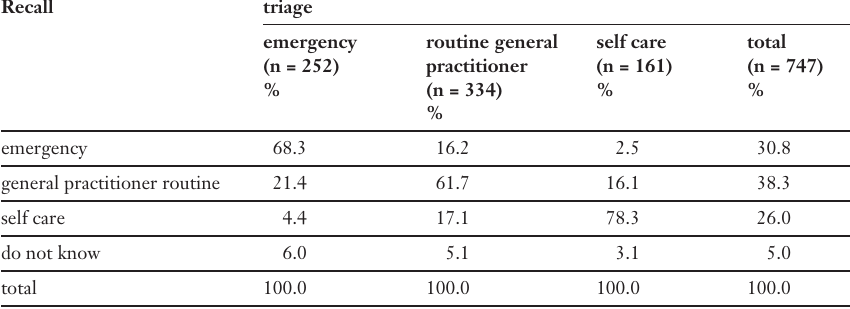
Triage advice and patients recall.